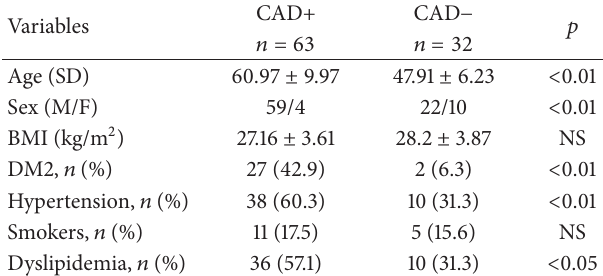
Table 3: TAT concentrations on the risk of CAD after adjusting for traditional CAD factors using conditional logistic regression model.